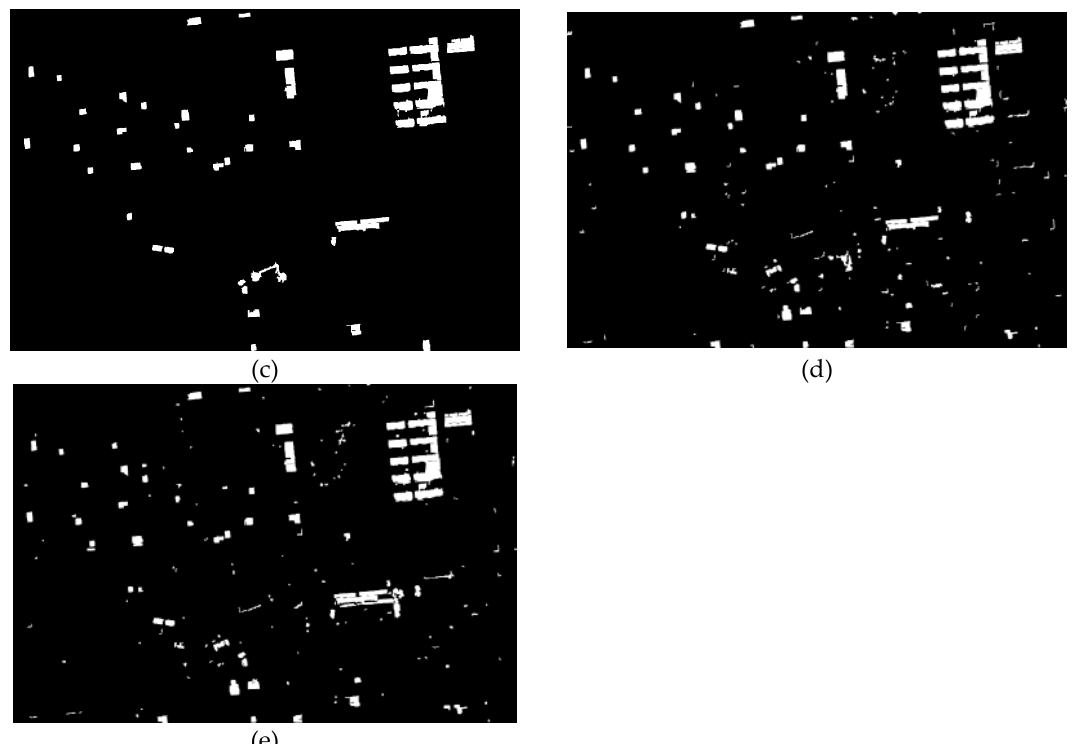
Figure 7. Building change detection results (white - building changes; black – other changes or non-changes) under segmentation scale: ( a ) Q = 16, ( b ) Q = 32, ( c ) Q = 64, ( d ) Q = 128, and ( e ) Q = 256.